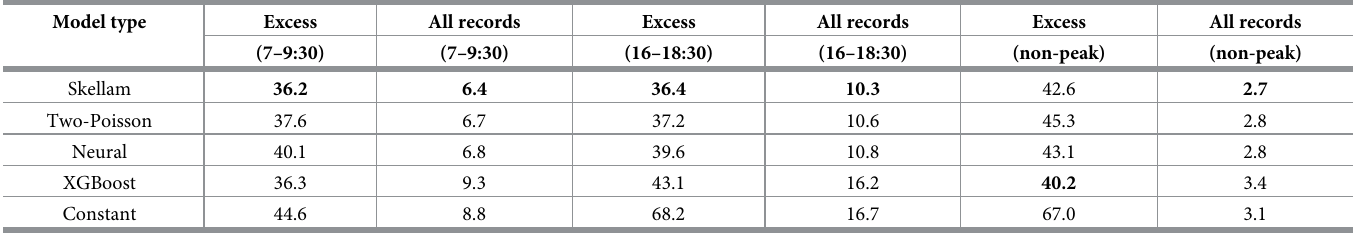
Table 3. MSE of different time